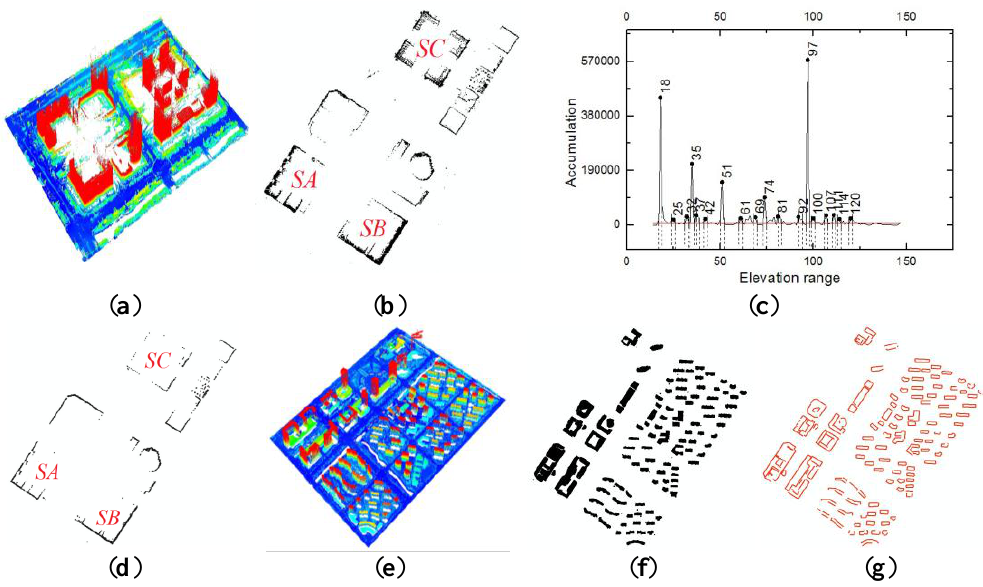
Figure 9. Building contour extraction of Area A . ( a ) Vehicle LiDAR data; ( b ) Elevation difference filtering; ( c ) Height value accumulation; ( d ) Vehicle building contours; ( e ) Airborne LiDAR data; ( f ) RIMM for buildings; ( g ) Airborne building